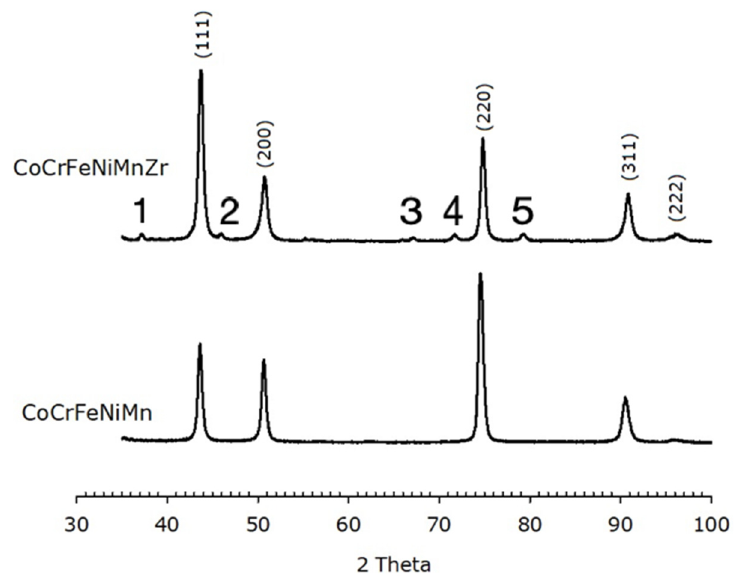
Figure 7. XRPD data of of Zr-CoCrFeNiMn (top) and CoCrFeNiMn (bottom) after recrystallization, showing an FCC structure. The Miller indices of the lattice planes are indicated. Peaks labelled with numbers from 1 to 5 are due to oxides. Numbers 1, 4 and 5 correspond to the (110), (121) and (220) peak of ZrO 2 , respectively. Numbers 2 and 3 are not clearly identified.